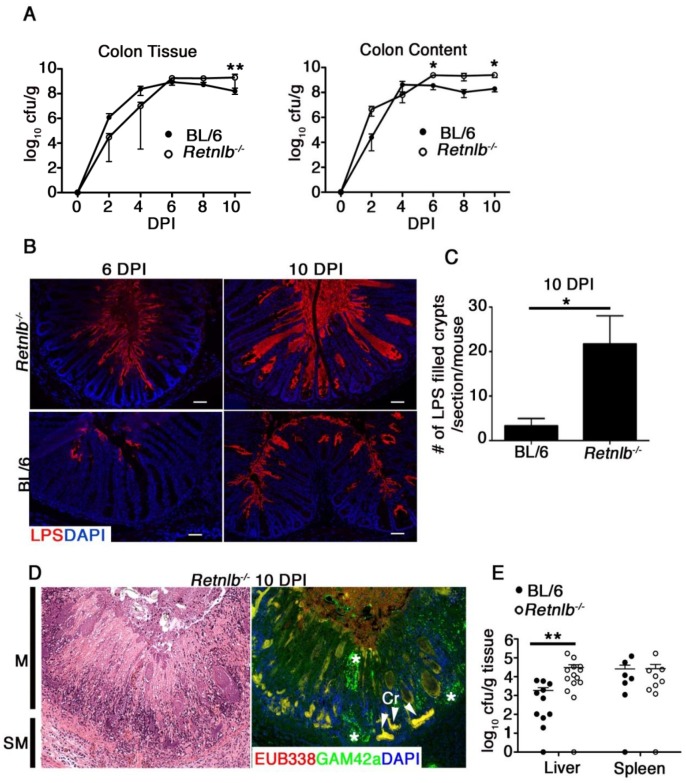
Disease severity of Retnlb
-/- mice is associated with greater C. rodentium invasion of colonic crypts.(A) C. rodentium enumeration in the colon tissue and luminal compartments of Retnlb
-/- and C57BL/6 following infection. Results show means of 3–4 (2 and 4 DPI) and 6–11 (6–10 DPI) animals, and are representative of 2 independent experiments **P = 0.0047, *P = 0.0262; ##
P = 0.0015 (Retnlb
-/- vs. C57BL/6); Mann-Whitney U-test. (B) C. rodentium staining in mouse colonic tissues (6 & 10 DPI). Original magnification = 200X. Results are representative of 4–6 mice/group. (C) Quantitation of C. rodentium LPS-filled crypts in Retnlb
-/- and C57BL/6 mice (10 DPI). Results represent mean of total crypts counted in single mice, pooled from 3–6 mice/group. *P < 0.05. (D) Left panel: H&E staining of heavily ulcerated colonic tissue from a Retnlb
-/- mouse (10 DPI). M = Mucosa; SM = submucosa. Right Panel: dual FISH staining using a universal EUB338 probe (red) and Gamma-proteobacteria specific probe (green), revealing clusters of C. rodentium (yellow) deep within ulcerated tissue, presumably where crypt bases were located. Cr—C. rodentium. Results are representative of all ulcerated Retnlb
-/- mice analyzed (n = 5). (E) Enumeration of systemic C. rodentium burdens in C57BL/6 vs. Retnlb
-/- mice (10 DPI). Each data point represents one animal. **P = 0.0037, Mann-Whitney U-test.